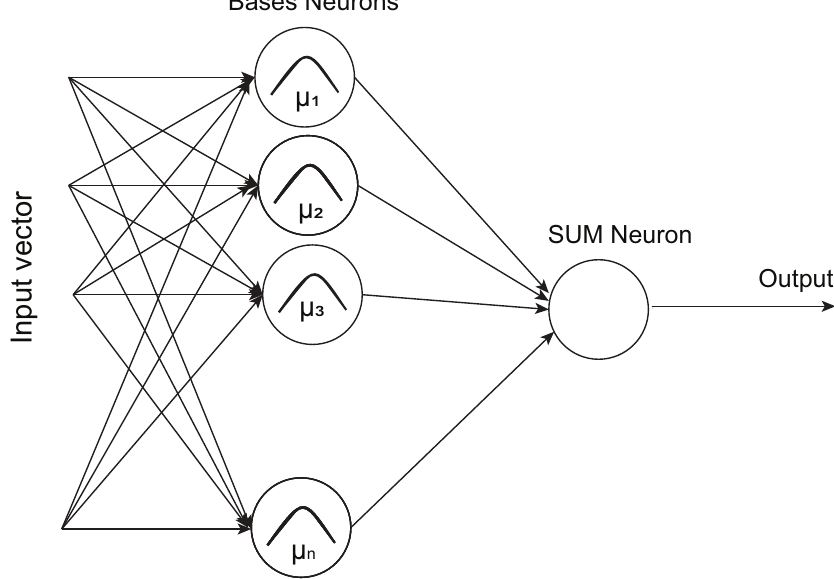
Figure 1. Representation of RBF